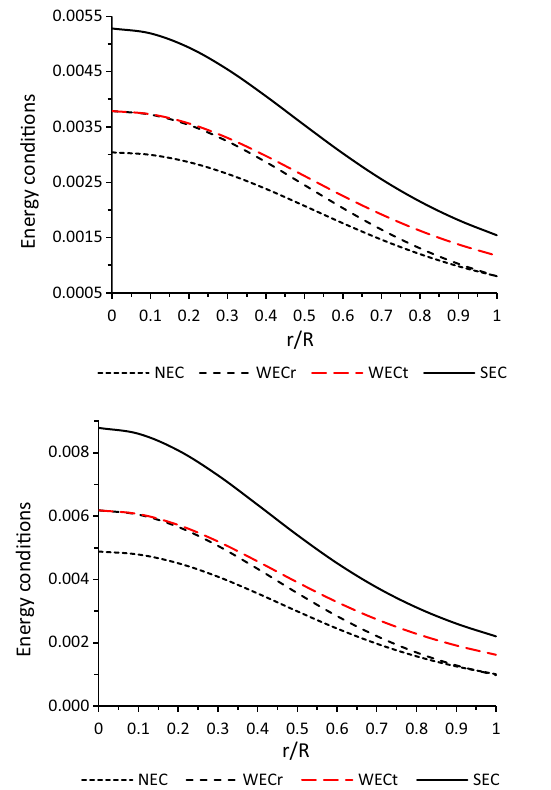
Fig. 6 Behaviorofradialvelocity( v 2 r )andtangentialvelocity( v 2 t )ver- sus radialcoordinates r / R .For plottingofthis figure, thecorresponding values of arbitrary constants or parameters are displayed in Table